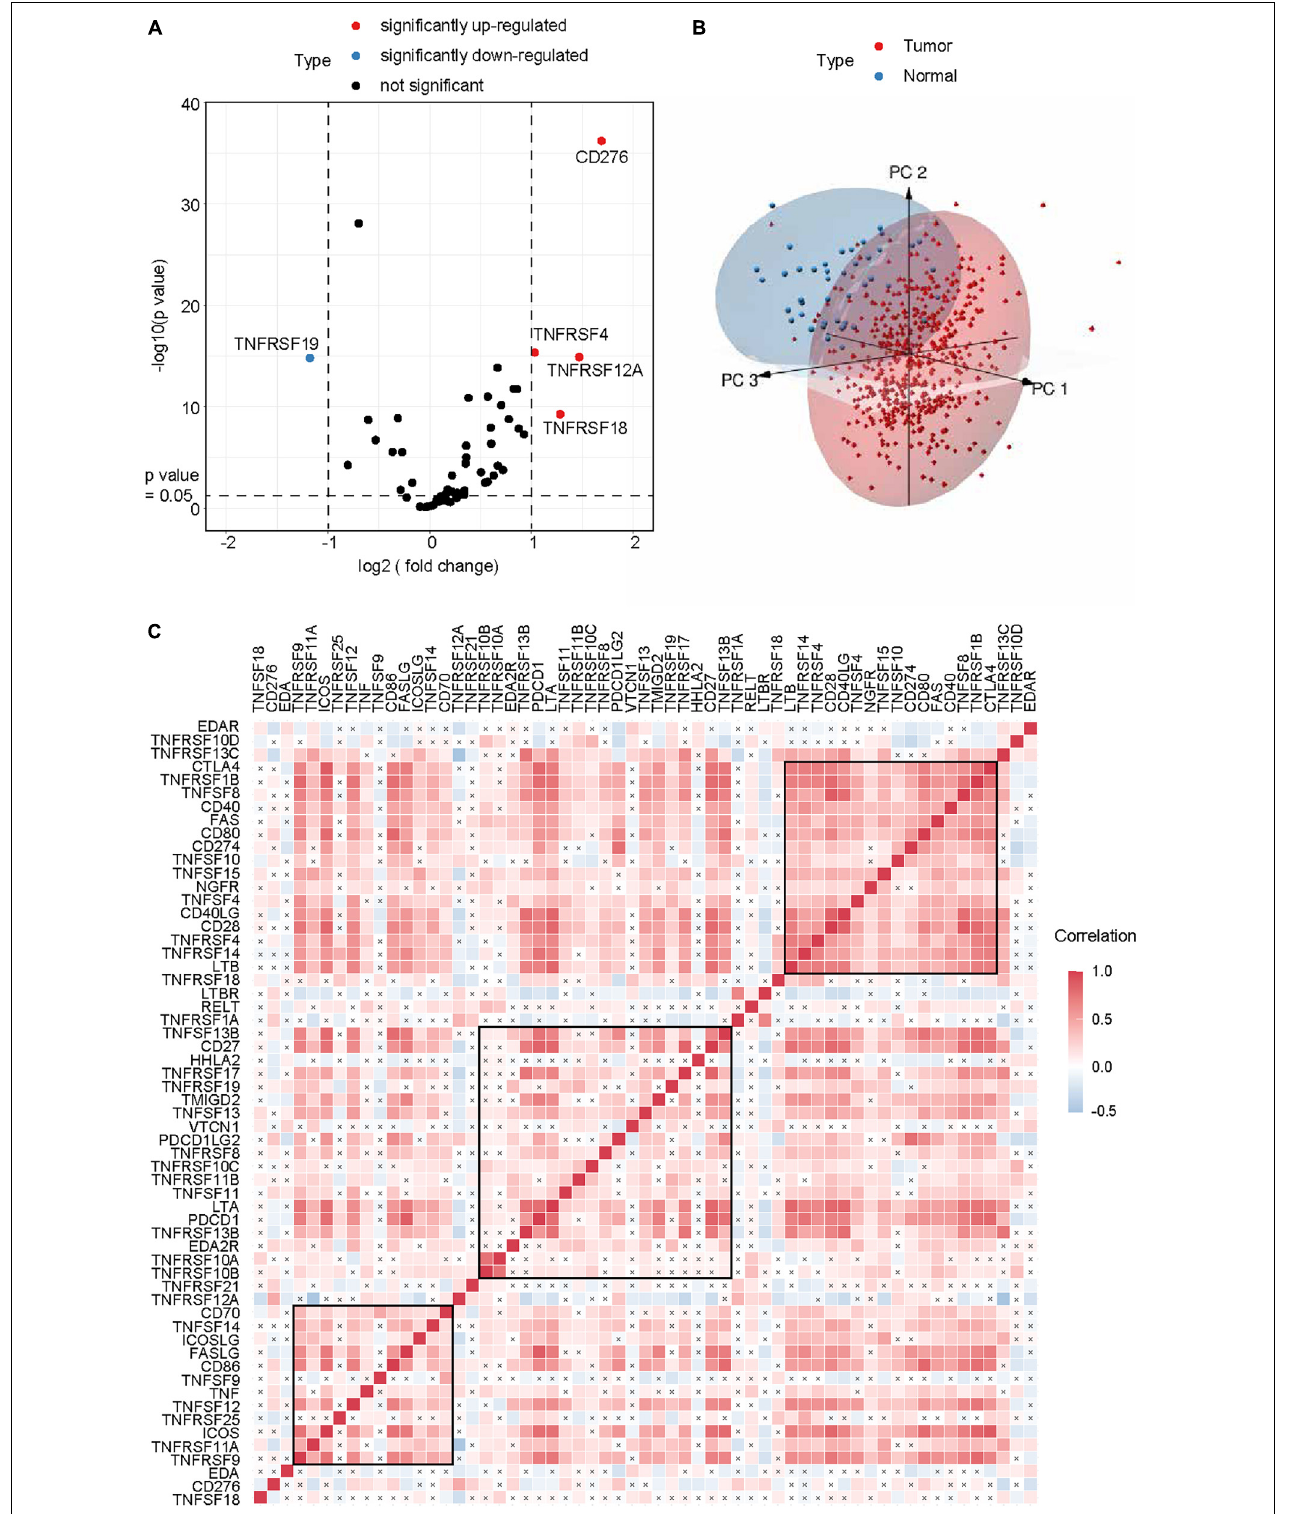
FIGURE 1 | Genomic landscape of CMGs in HNSCC. (A) Volcano plot exhibited the different expression patterns of CMGs between HNSCC tumors and normal tissues. (B) PCA for the expression profiles of CMGs to distinguish HNSCC tumors from normal tissues. (C) Correlation analysis of CMGs in HNSCC by Spearman. The black cross represented the p value >